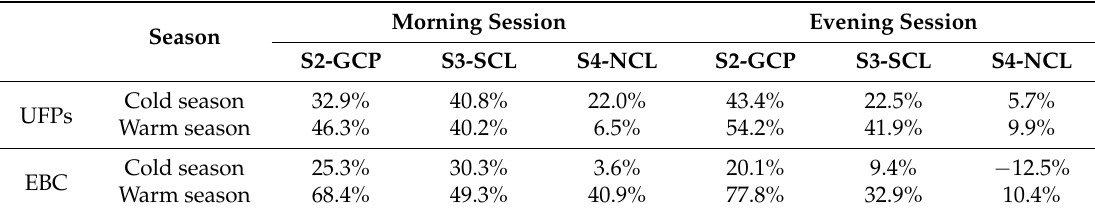
Table 3. Relative differences between the average exposure concentrations for road sectors S2-GCP, S3-SCL, and S4-NCL with respect to sector